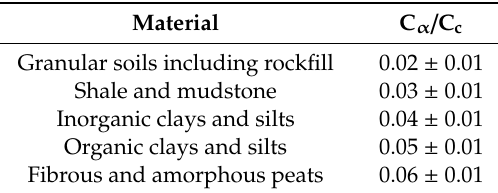
Table 8. Values of C α / C c for di ff erent soils.